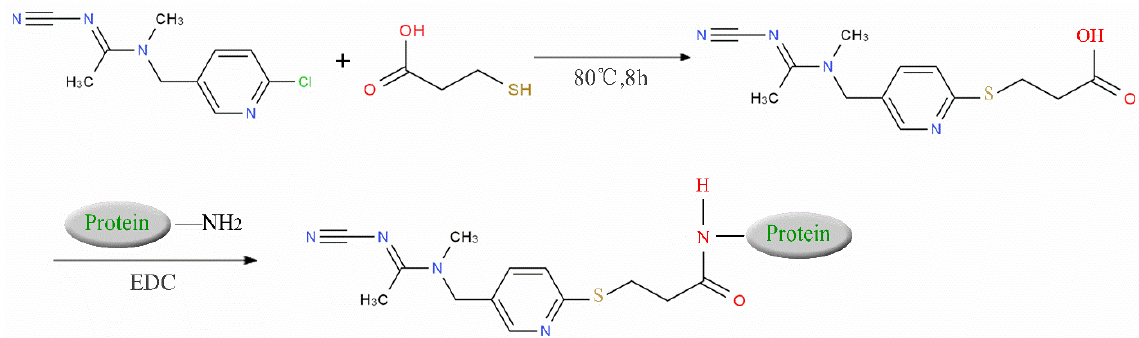
Figure 1. ACP coupling to form complete antigen.